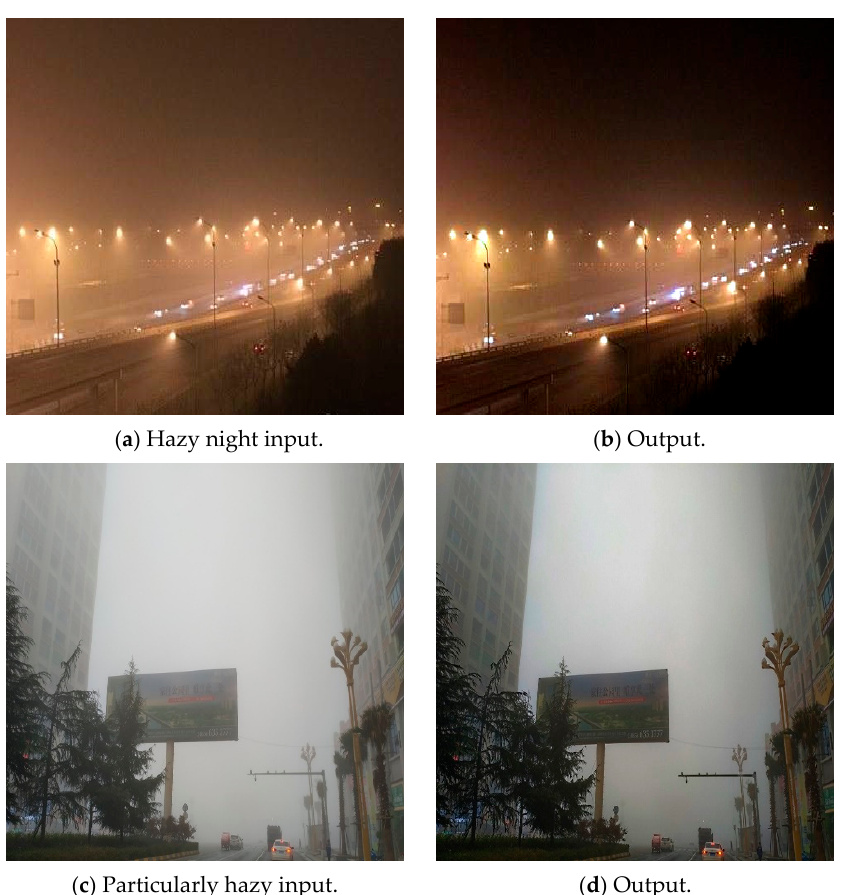
Figure 8. The results of our method on a hazy night image and on a particularly hazy image.